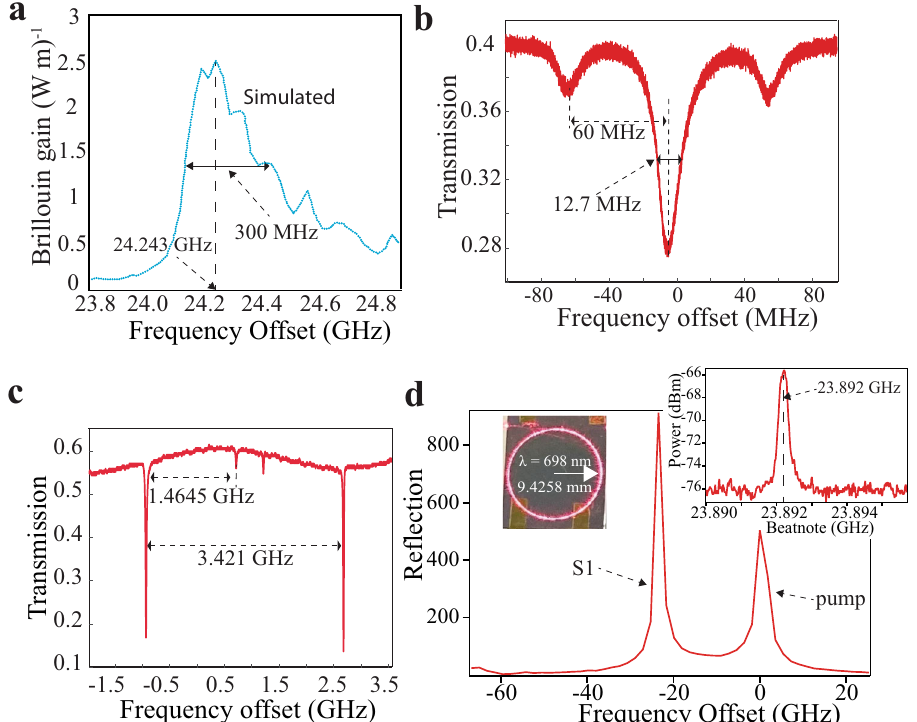
Fig. 5 SBS lasing at 698 nm. a Multi-physics simulation of waveguide spontaneous Brillouin gain spectra for pump at 698 nm. Brillouin gain spectrum width of ~300 MHz and Stoke frequency shift of 24.243 GHz. b The measured full width half maximum (FWHM) resonator linewidth at 698 nm is 12.7 MHz and the measured intrinsic and loaded Qs are 60 million and 33.8 million respectively. c The resonator free-spectral range (FSR) at 698 nm is measured to be 3.421 GHz by applying sidebands at 1.4645 GHz. d First order Stokes (S1) and the pump measured on an optical spectrum analyzer (OSA), with inset showing the pump-S1 beat note measured at 23.892 GHz on an electric spectrum analyzer (ESA). Inset on left shows the 9.4 mm radius resonator fi ber-coupled with 698 nm pump laser